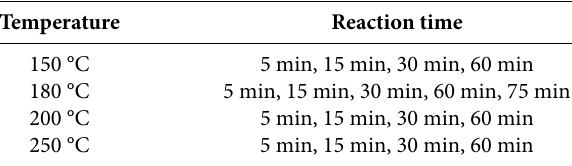
Table 1. SubCW reaction conditions